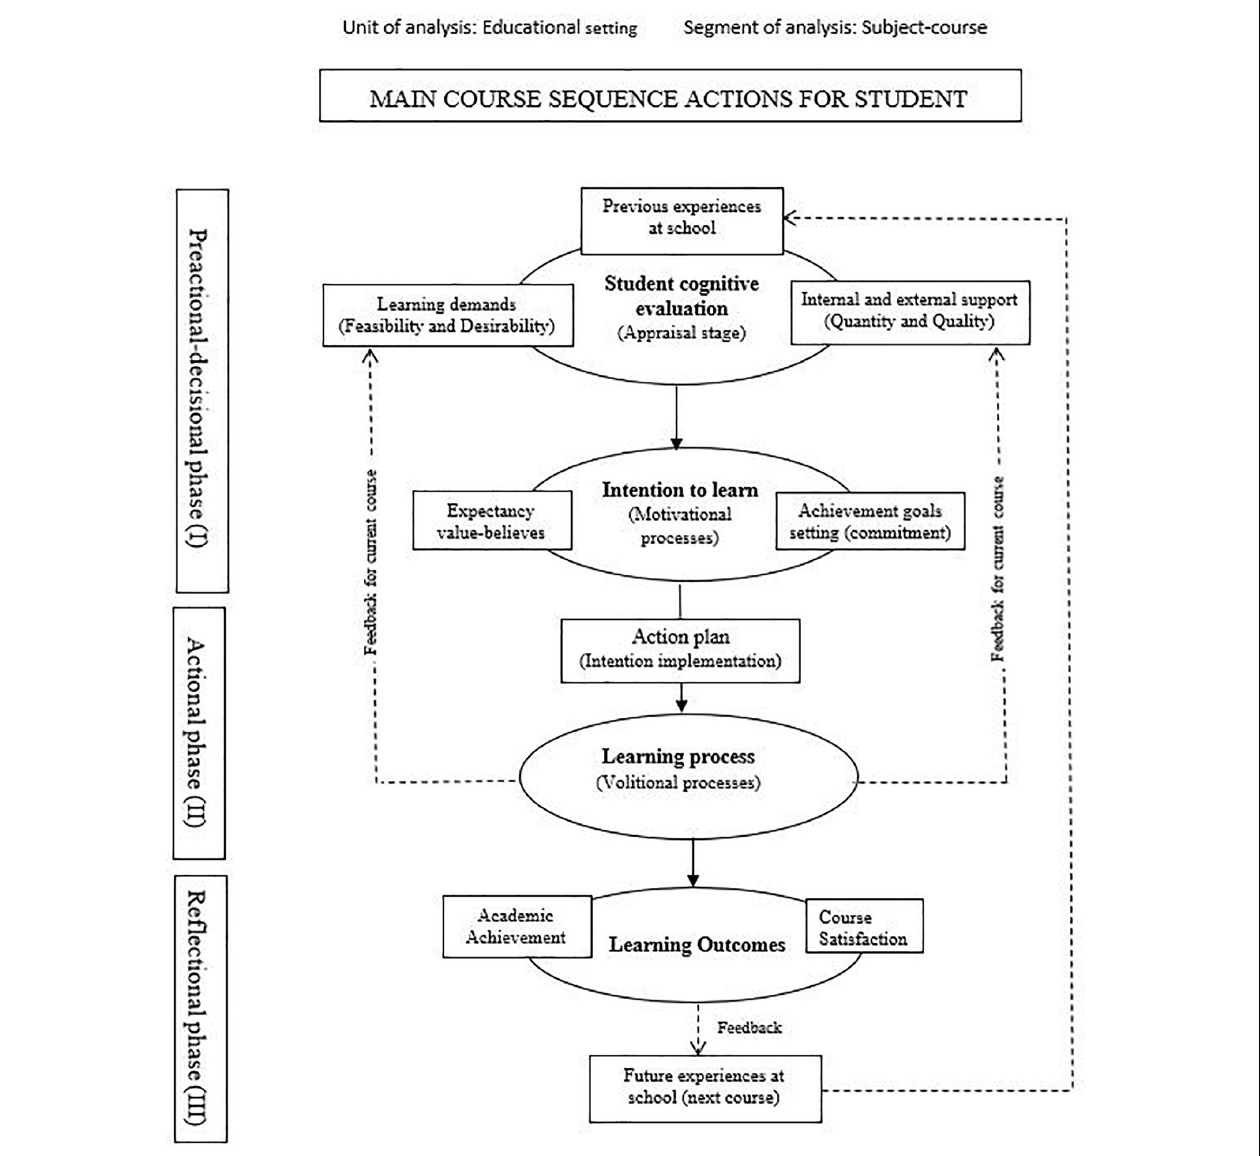
FIGURE 1 | MOCSE diagram: Main course sequence actions for students. 1 Connected with students’ interests, needs, and academic level (meaningful demands, Doménech-Betoret,